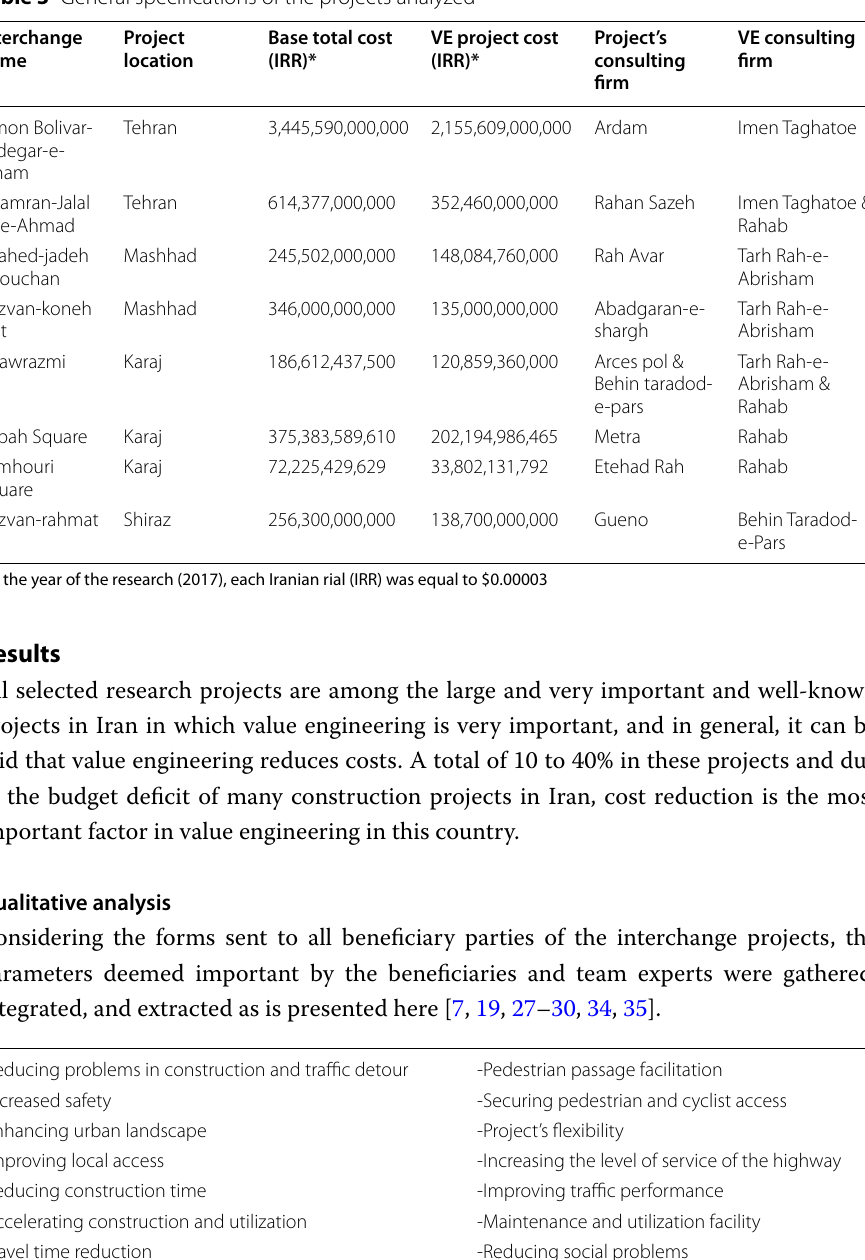
Table 3 General specifications of the projects analyzed